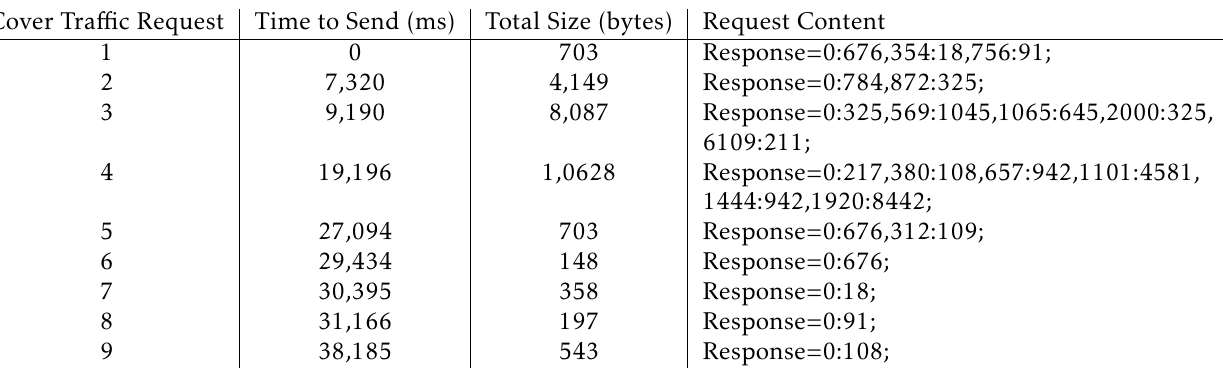
Table 1. Cover traffic requests based on one recorded real web traffic trace. The request content contains the number of responses to